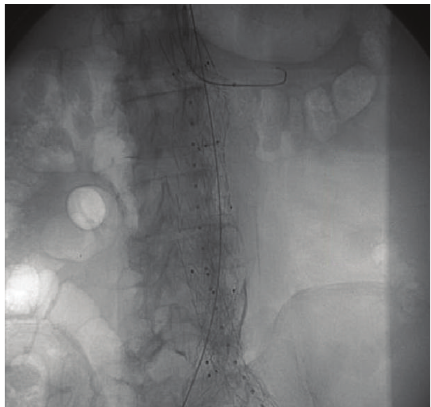
Figure 2: Fluoroscopy image of EVAR